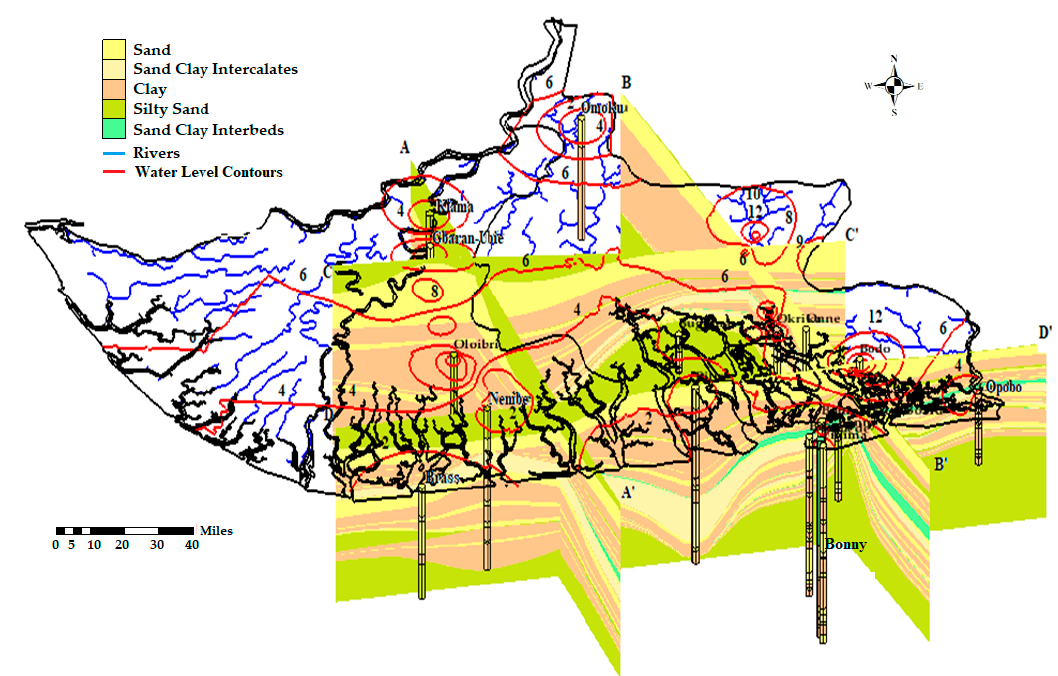
Figure 7. Fence diagram showing hydrostratigraphic section within the Niger Delta basin.